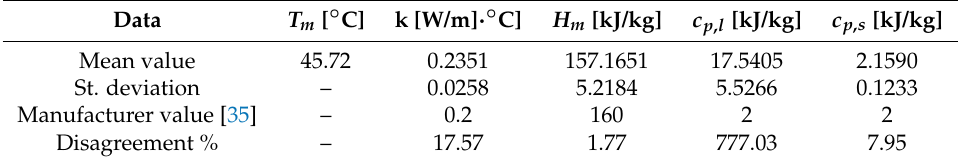
Table 4. Determination of thermal properties of RT45 with T-melting method.